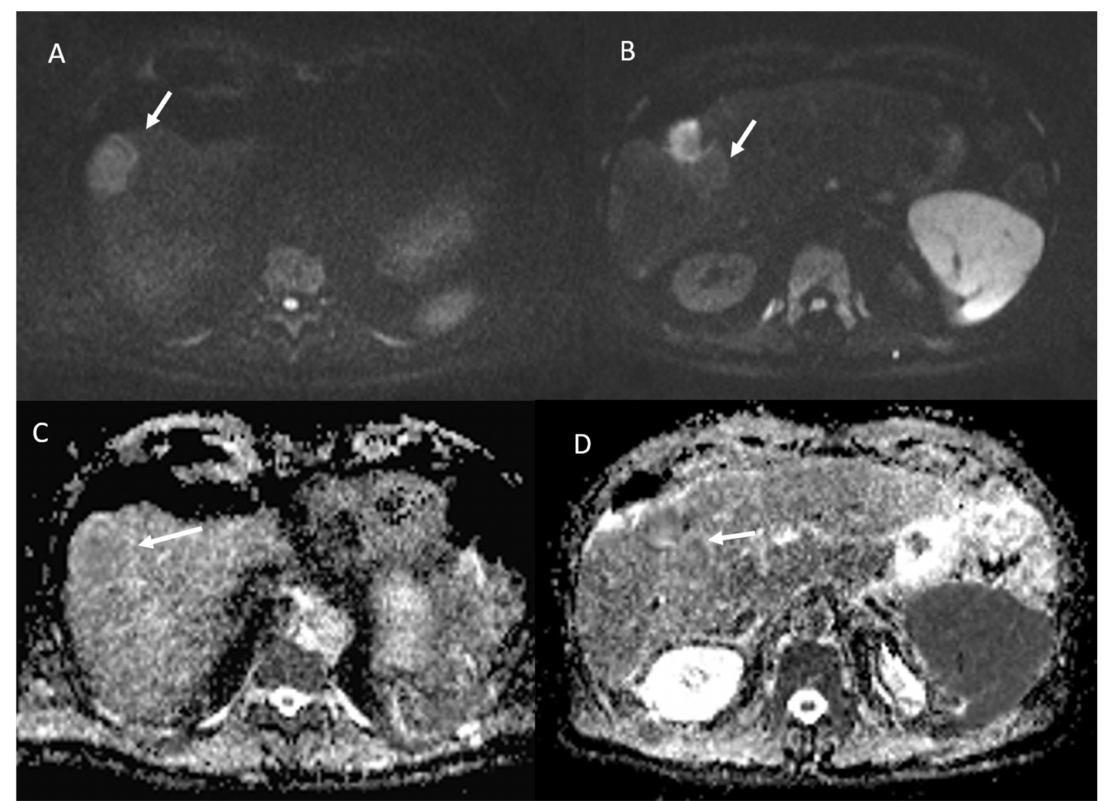
Figure 4. The same patient of Figures 2 and 3: in pre-treatment b800 s/mm 2 ( A ), the lesion shows restricted diffusion with isointense SI in ADC map ( C ); in post-treatment b800 s/mm 2 ( B ), viable lesion shows restricted diffusion with iso-hypointense S. in ADC map ( D